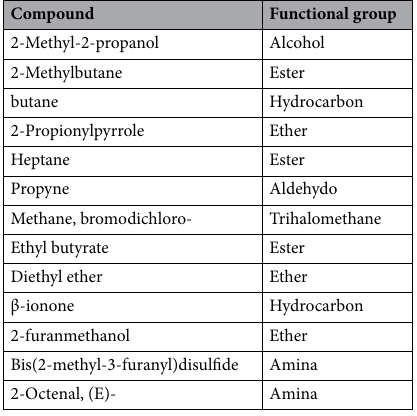
Table 2. Urine metabolomic compounds with an indiscrimination index of